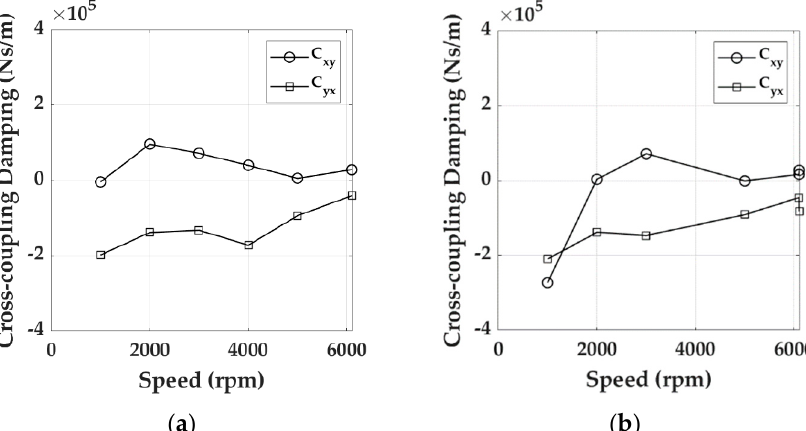
Figure 35. Flooded Rocker Pivot bearing synchronous direct damping: ( a ) 1.3 MPa, ( b ) 2.1 MPa.